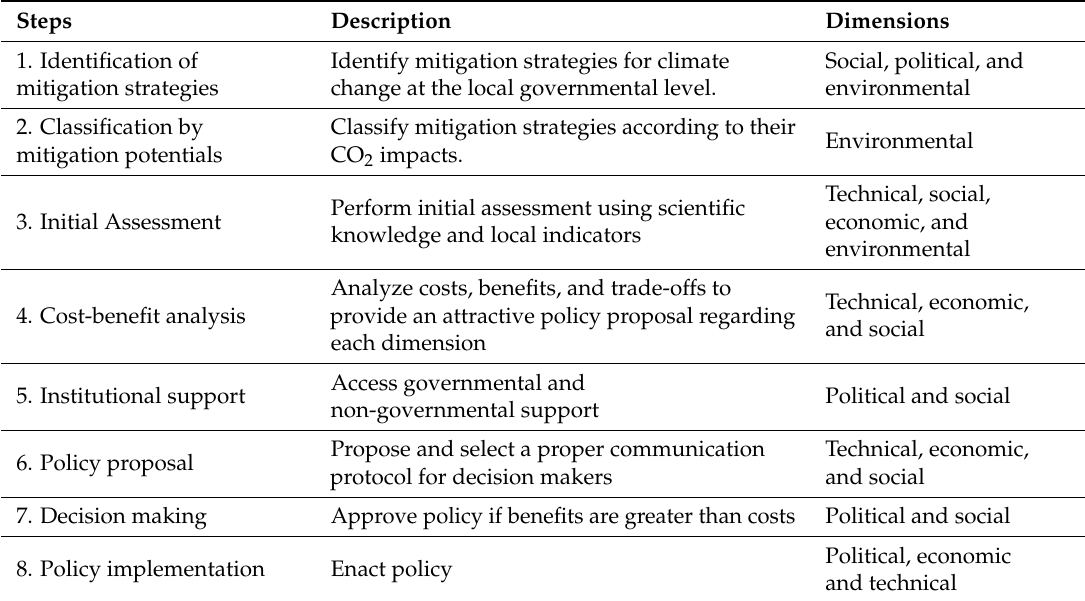
Table 2. Description of the eight steps of the methodology and the dimensional interactions involved in each